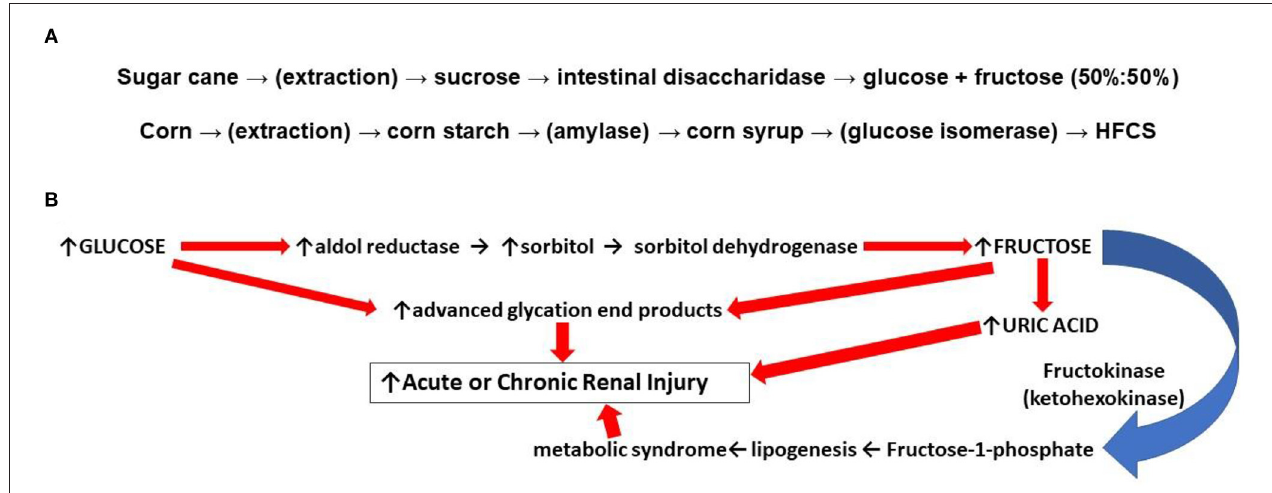
FIGURE 1 | (A) (top): Differences in food sweeteners from sugar and corn. Sucrose is extracted from sugar cane or beets. Ingested sucrose from processed foods is digested in the small intestines by disaccharidase into equal parts glucose and fructose (50%:50%). Absorbed fructose is almost completely taken up by GLUT-1 and GLUT-5 transporters in the liver which accounts for low levels of plasma fructose. Corn starch is a polysaccharide that is enzymatically hydrolyzed to monosaccharides which in the presence of isomerase increases the relative content of fructose yielding a high fructose corn syrup (HFCS). (B) (bottom): Some mechanisms by which fructose can result in renal injury. The endogenous conversion of glucose to fructose through the polyol pathway contributes to formation of uric acid, which promotes mitochondrial oxidative stress and inflammation. Endogenous fructose generation also promotes lipogenesis which contributes to the development of the metabolic syndrome. Glucose and fructose can both react directly with cellular lipids and proteins; oxidized LDL and collagen cross linked by these reactions can induce vascular stiffness, stimulate inflammation, and promote atherogenesis ( 4).